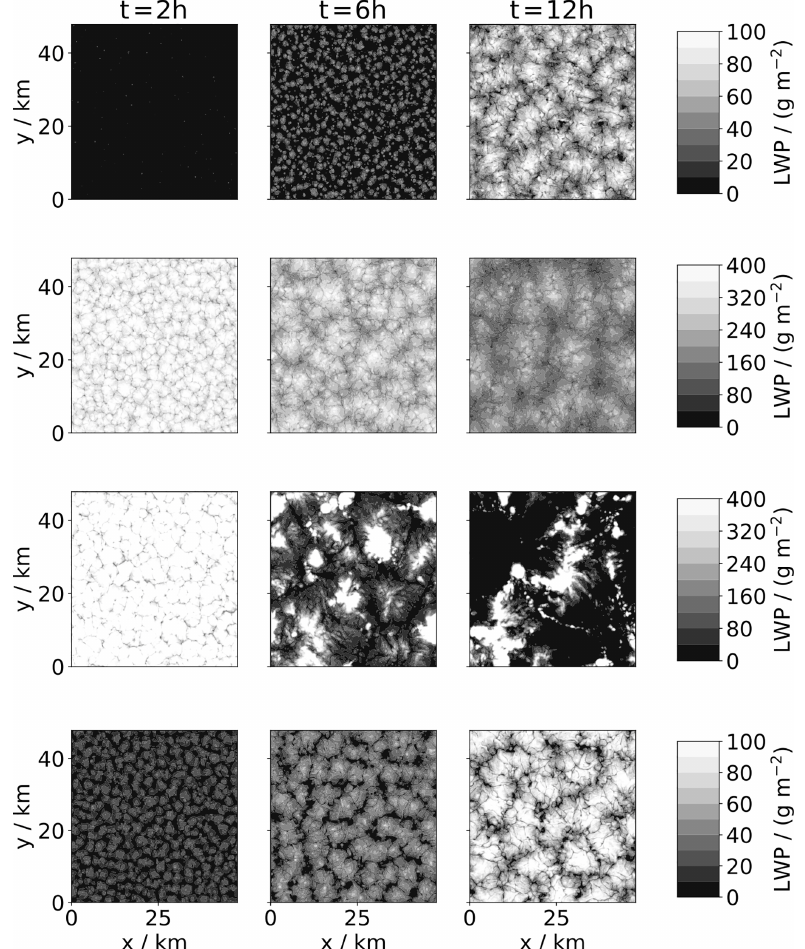
Figure 2. Horizontal arrangement of liquid water path (sum of rain and cloud water) for trajectories (top row) A to (bottom row) D from Fig. 1. The left column shows t = 2h, which corresponds to the gray circles in Fig. 1. The right column shows the last time step ( t = 12h) and the central column shows t =